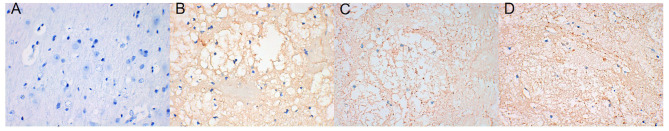
AQP4 increased significantly in brain tissue on days 1, 3, and 7 after intracerebral hemorrhage (the yellow-dyeing part indicated by the arrow was where AQP4 located, and the blue part was the nucleus). (A) Sham group. (B) ICH 1d group. (C) ICH 3d group. (D) ICH 7d group.